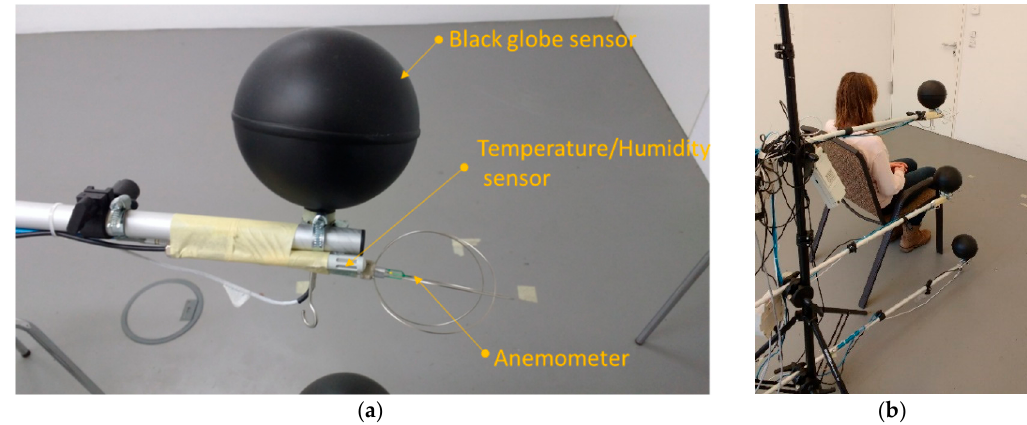
Figure 5. (a) Sensors (air temperature/humidity, air velocity, and globe temperature) and ( b ) their positions at 10, 60 and 110 cm from the floor.